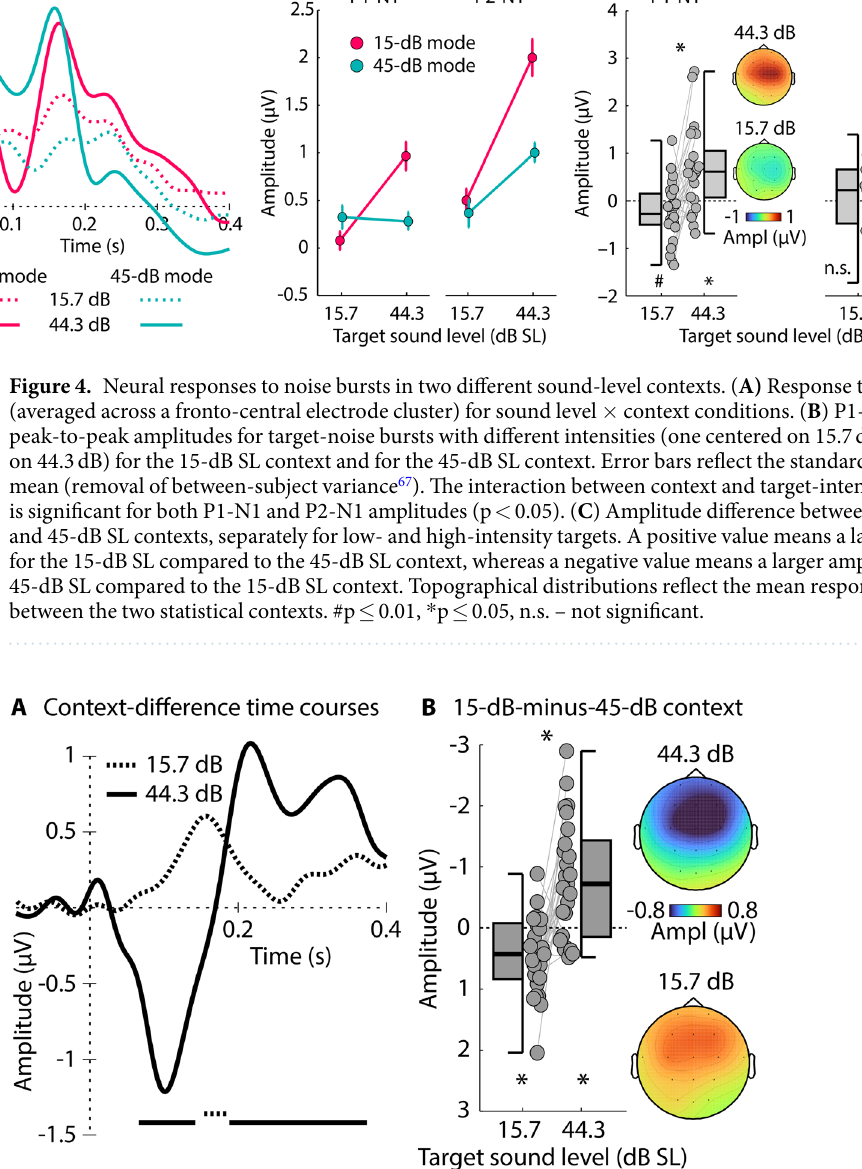
with an intensity higher than 30 dB SL (mean of 44.3 dB SL). Perceptual sensitivity (d’) was calculated for both target-intensity categories and for both statistical contexts (Fig. 7A), for each participant. Performance on the task was good, with all conditions exceeding a mean d’ value of 2. An rmANOVA indi- cated that the two factors Context and Target-Intensity Category exhibited a significant interaction (F 1,32 = 34.610, p = 1.5 × 10 − 6 , η 2 p = 0.520; Fig. 7A). Comparing d’ values between the two contexts, separately for each target-intensity category (lower-intensity targets centered on 15.7 dB SL; higher-intensity targets centered on 44.3 dB SL), revealed higher perceptual sensitivity to AM in the 15-dB context compared to the 45-dB context for high-intensity targets (t 32 = 3.200, p = 0.003, r e = 0. 492), but higher perceptual sensitivity to AM in the 45-dB context compared to the 15-dB context for low-intensity targets (t 32 = –2.116, p = 0.042, r e = 0.350; Fig. 7B).